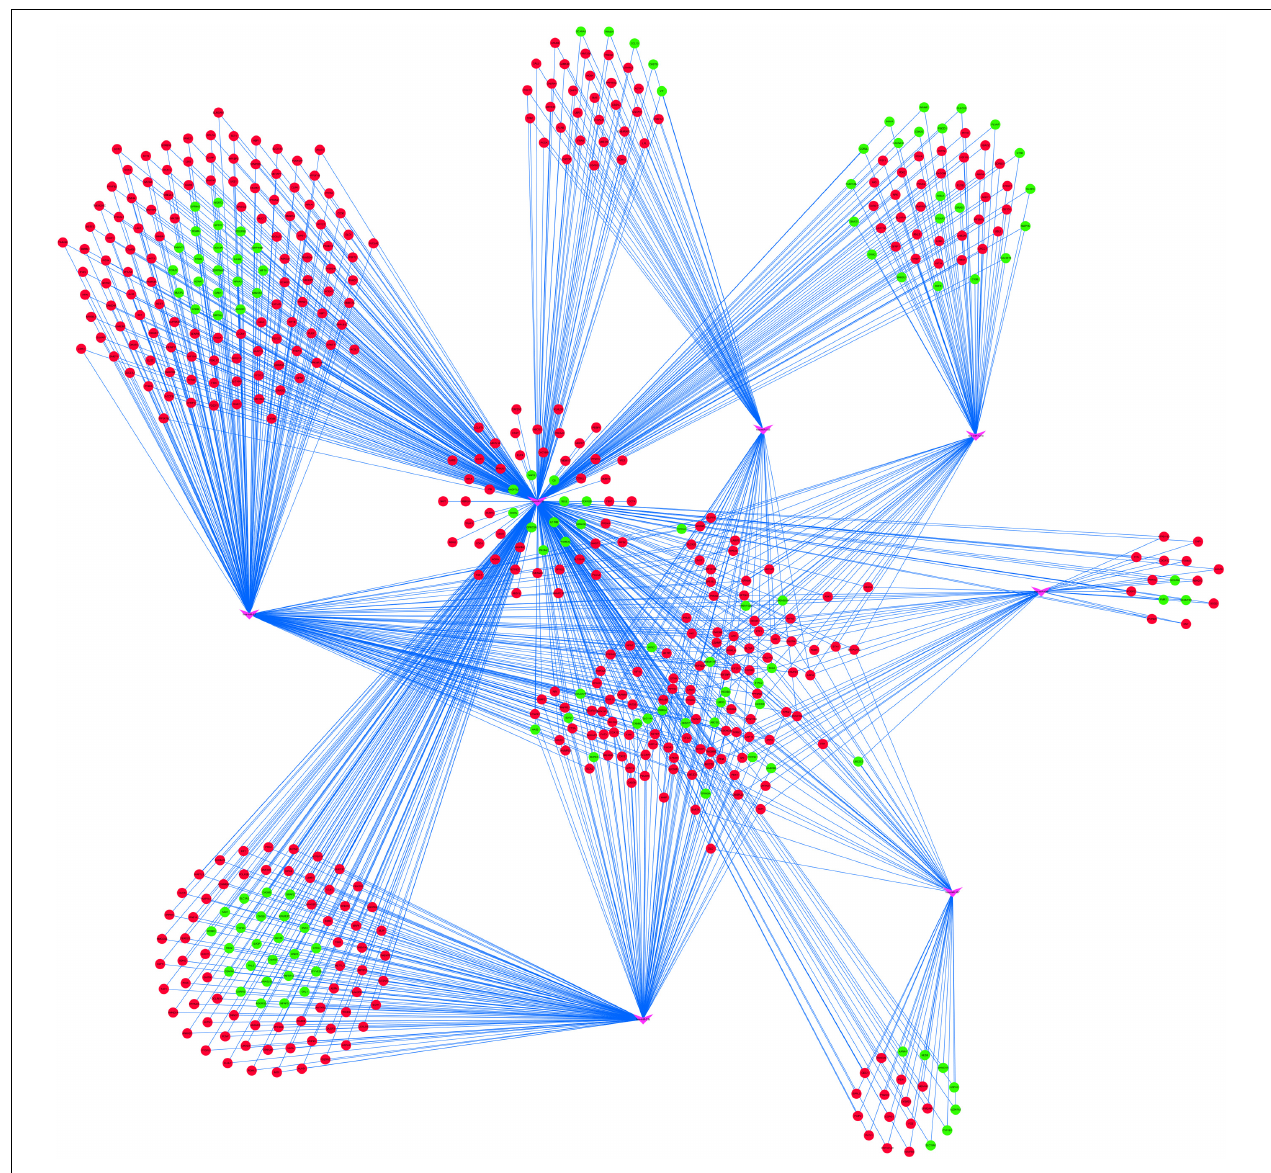
FIGURE 5 | miRNA–target regulatory networks of differentially expressed genes (DEmRNAs). The pink V-shapes represent miRNAs, red circles represent upregulated DEmRNAs, and green circles represent downregulated DEmRNAs.